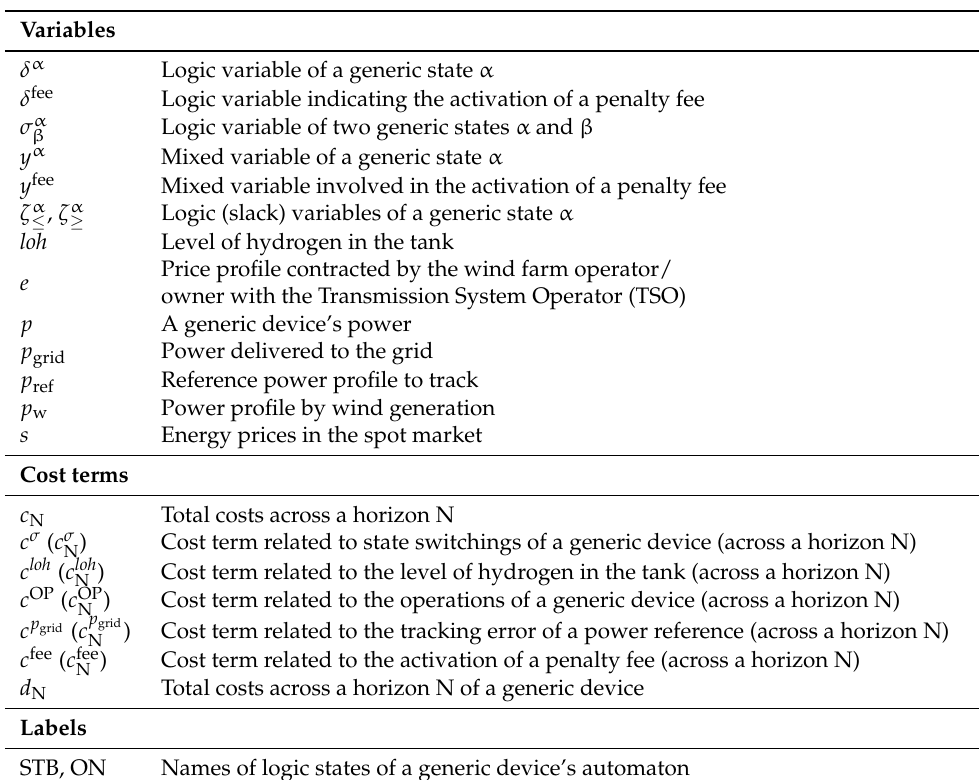
Table 1. List of